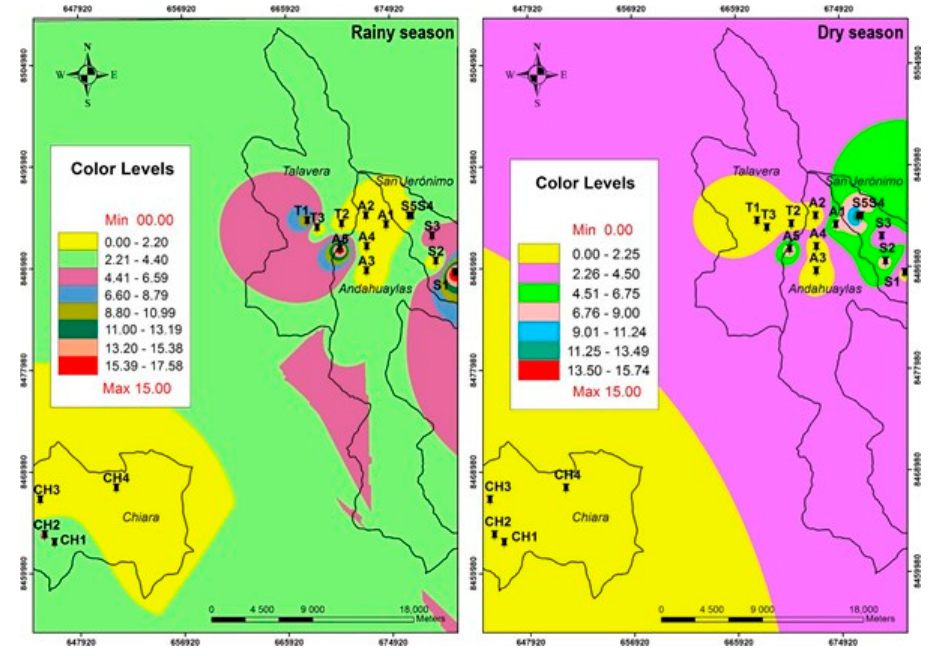
Figure 3. Variation of water color level in sampling areas. Table 4. Values of water quality parameters for human consumption.